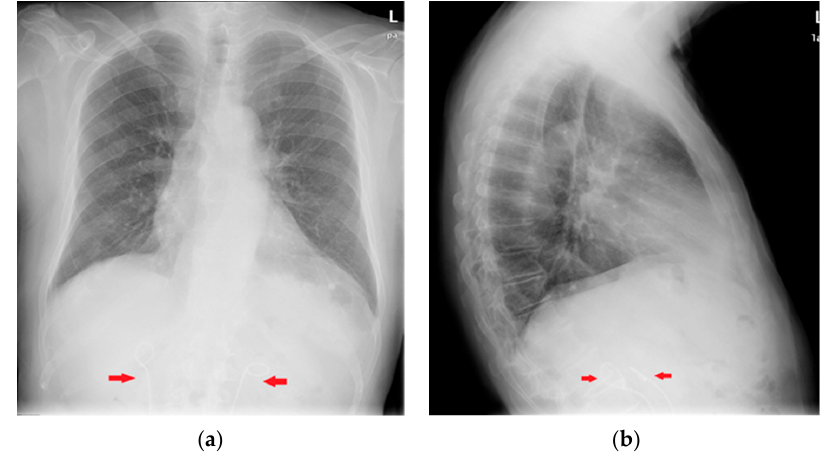
Figure 37. Image of an IVC filter on PA ( a ) and LL ( b ) views of a CXR (green arrows).